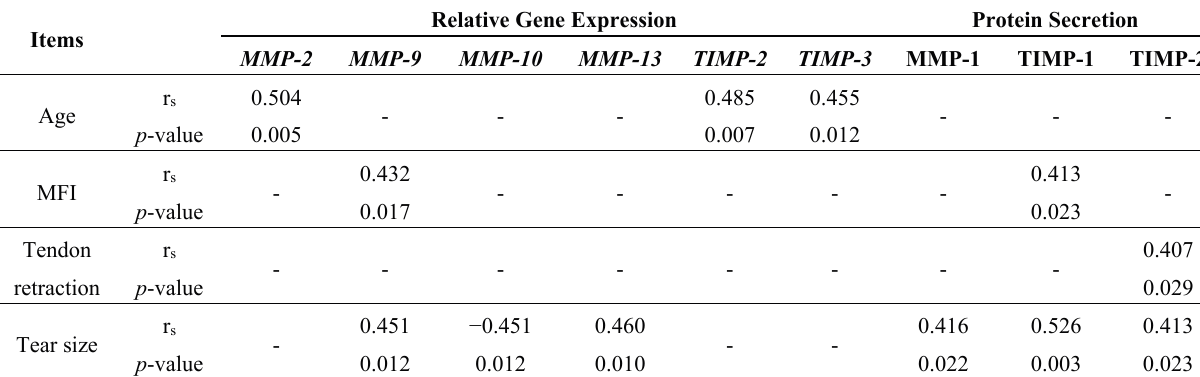
Figure 3. MMPs and TIMPs grouped according to the age of the donors (under 65 years ( n = 16) and over 65 years ( n = 14)). ( A ) qRT-PCR was performed to analyze gene expression. The box plot data represent the relative gene expression with 18S as reference gene using the Δ C t method with efficiency correction. The mRNA levels of MMP-2, -9, -13 and TIMP-2, -3 are significantly increased with higher age; ( B ) Protein levels were analyzed using ELISA and normalized to total protein content (Coomassie Plus assay). Protein levels of MMP-2 and TIMP-1 were significantly elevated with higher age. To allow visualization of all MMPs/TIMPs in one figure, MMP-9 and -13 values were multiplied by 10 5 . Table 1. Correlations between donor characteristics and MMPs and